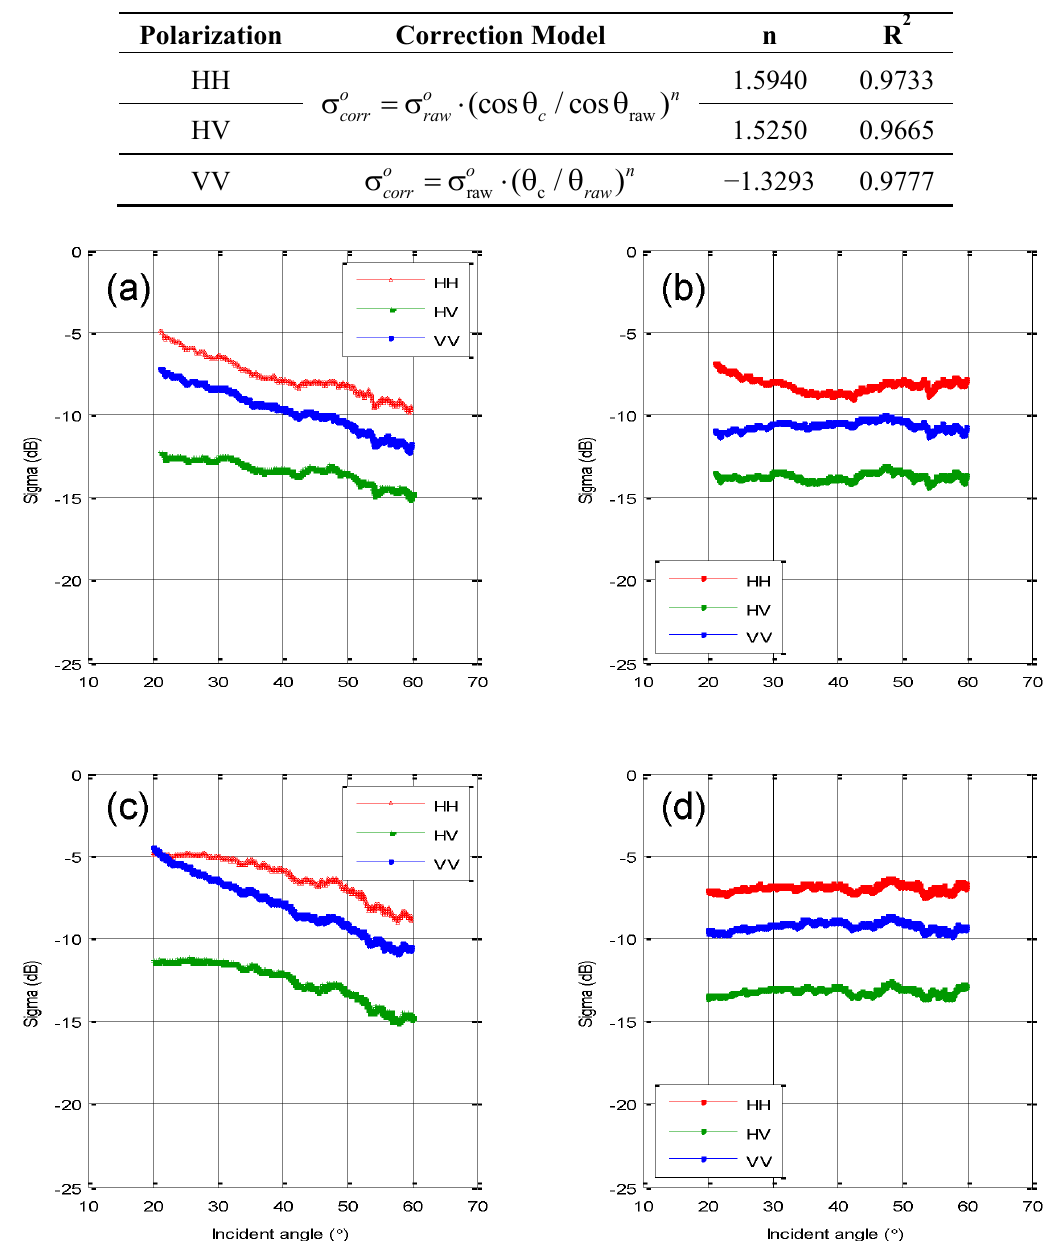
Table 2. Correction model parameters and coefficients of determinant for three polarizations.